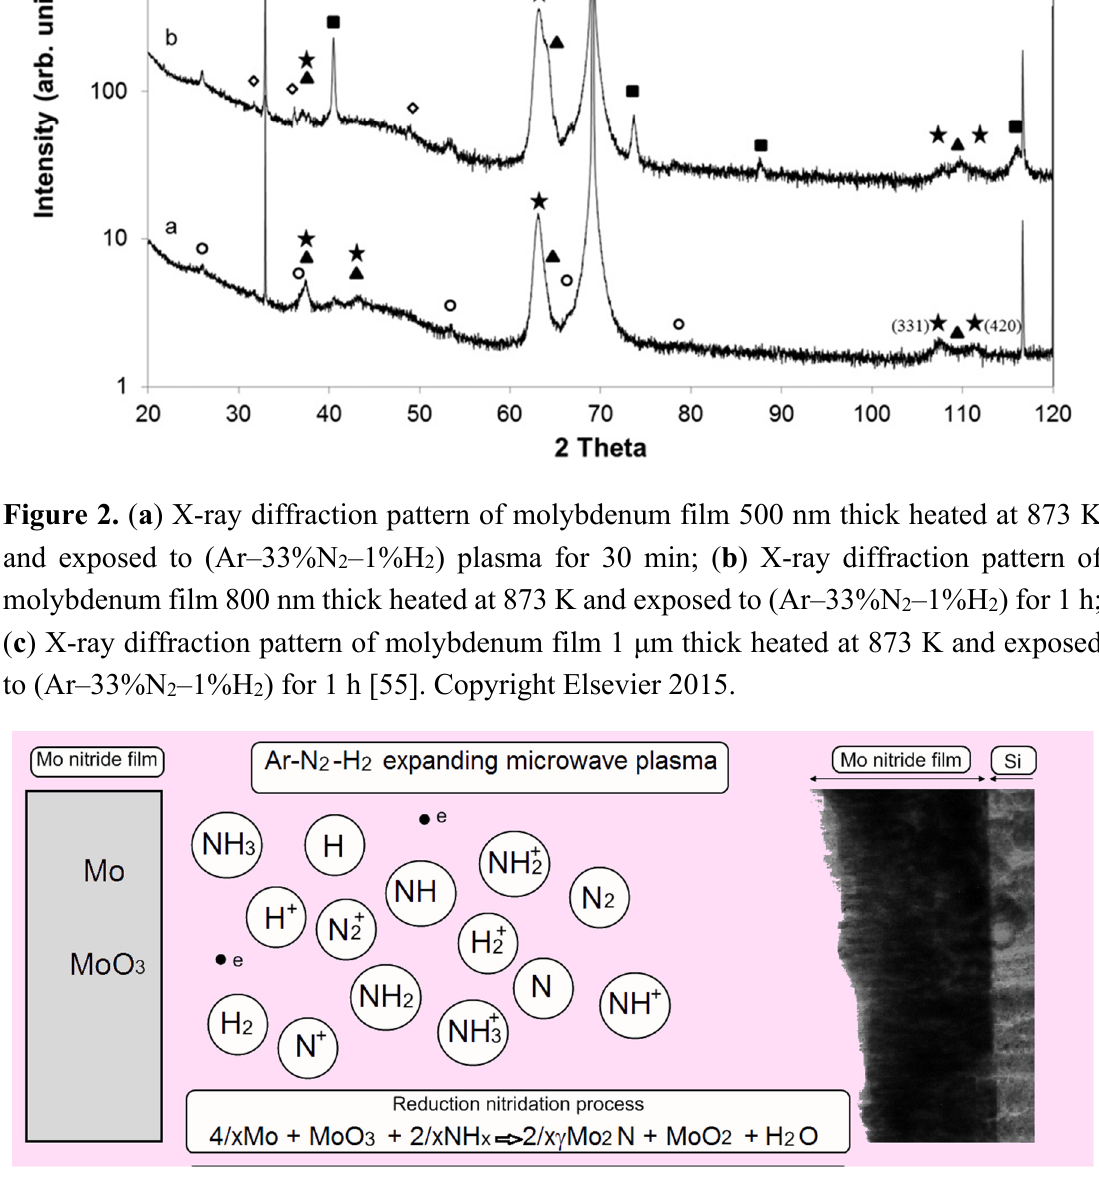
Figure 3. Schematic representation of the reduction-nitridation process that occurs during Mo film exposure to (Ar–N 2 –H 2 ) expanding microwave